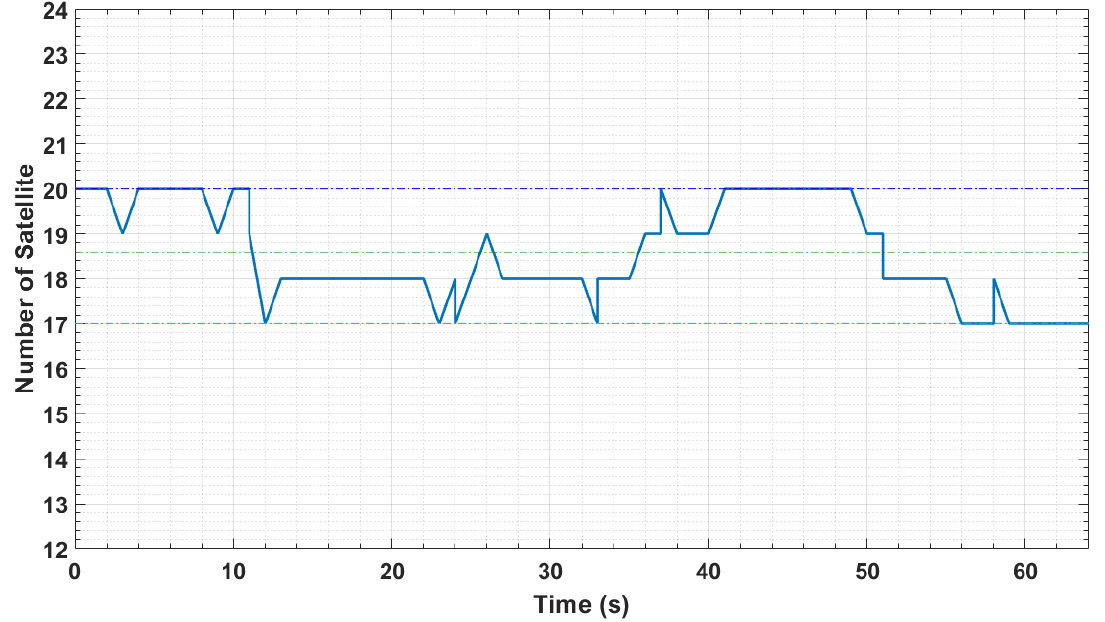
Figure 14. The number of satellites read by GPS on the USV.